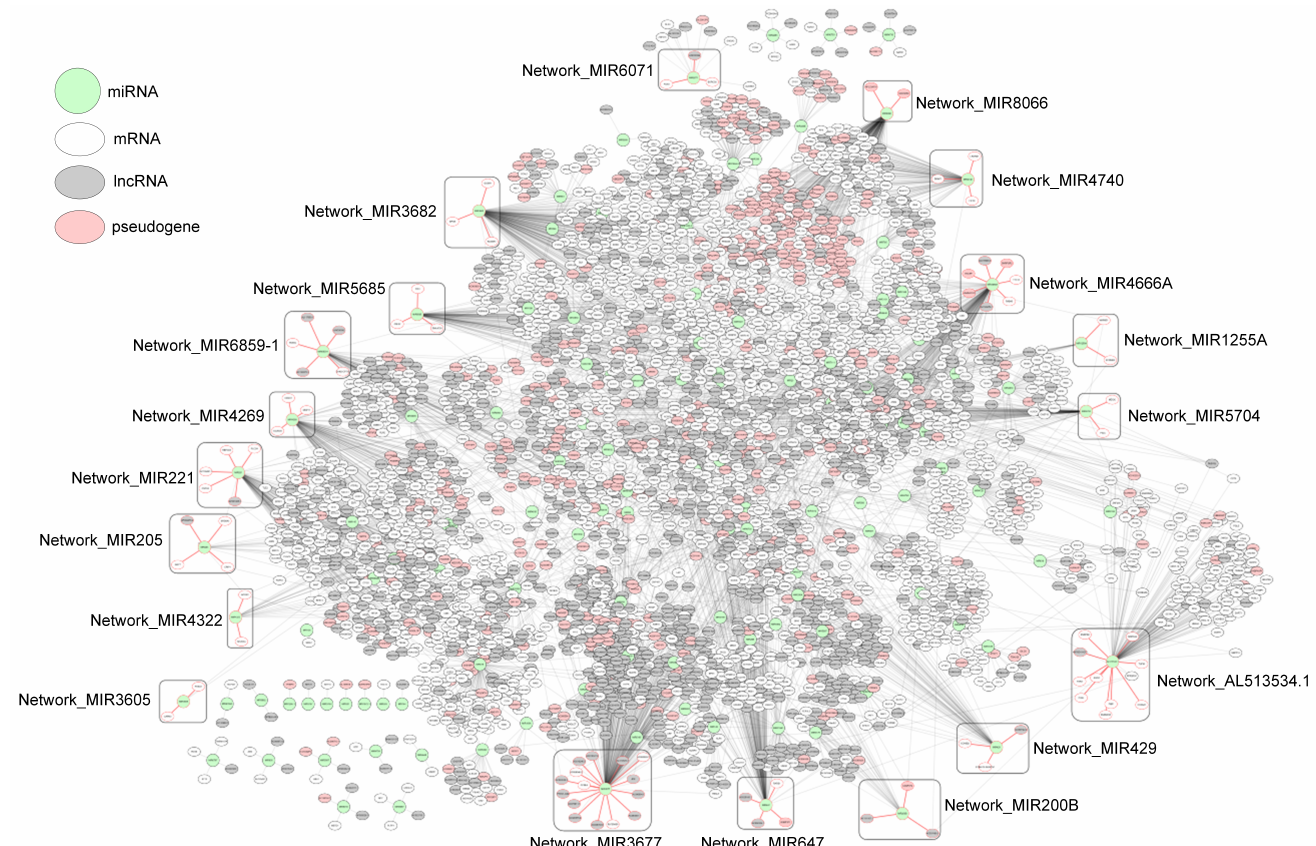
Figure 4. Network of miRNA–RNA correlations in PRAD, which consists of 5036 edges between 4121 nodes (125 miRNAs, 2330 mRNAs, 1169 lncRNAs, and 479 pseudogenes). Subnetworks enclosed with rounded boxes are potential prognostic network biomarkers found in our